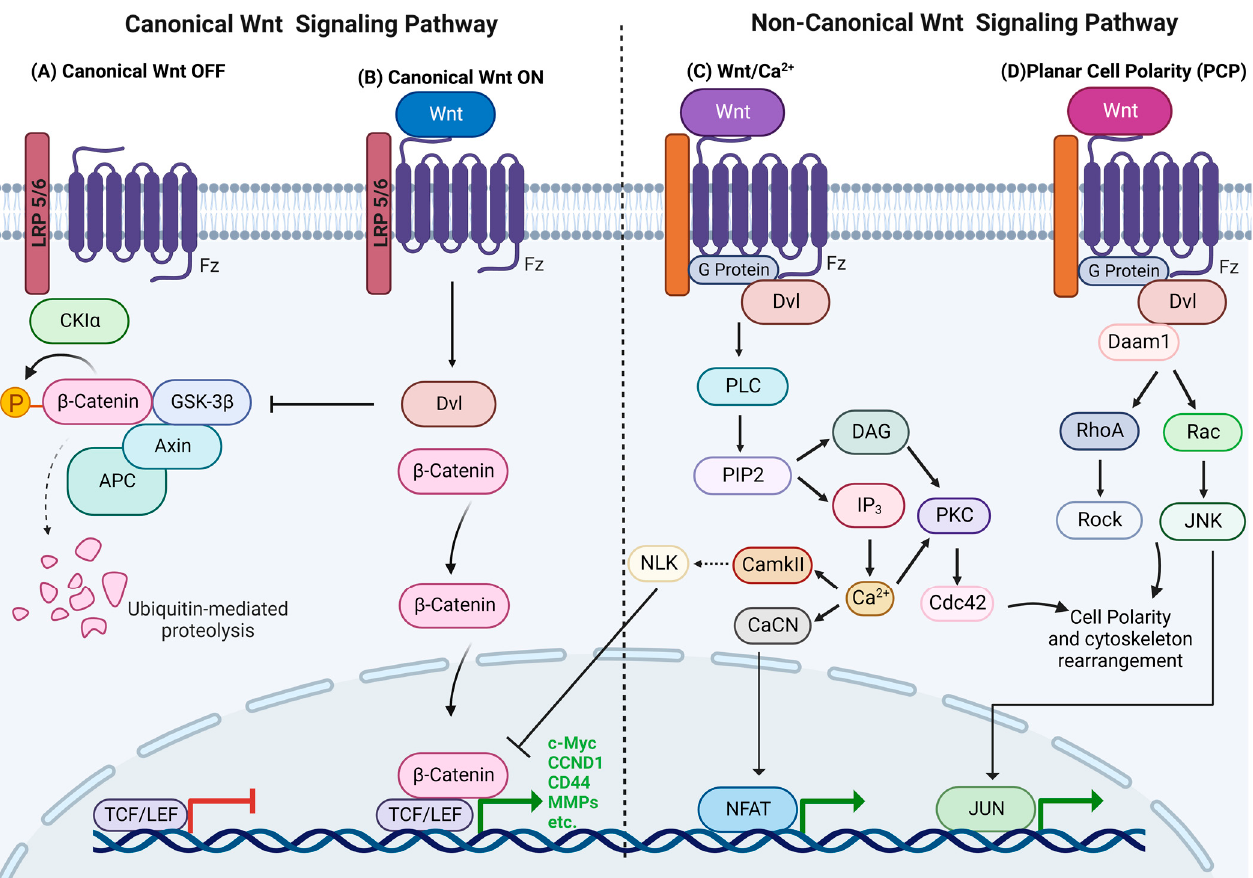
Figure 1. Overview of Wnt signaling pathways. ( A ) Canonical Wnt pathway off. ( B ) Canonical Wnt pathway on. ( C ) Non-canonical Wnt/Ca 2+ pathway and ( D ) non-canonical Wnt/PCP pathway.